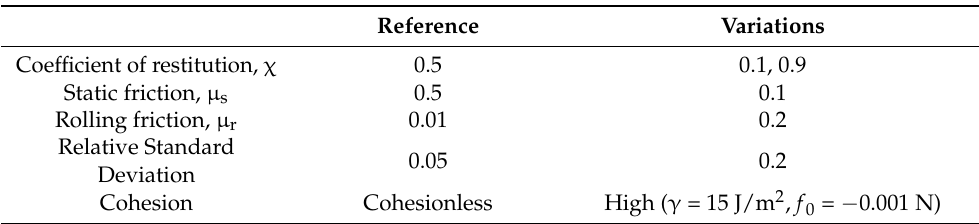
Table 4. Variations from the reference case defined in Table 3, where χ , µ s and µ r apply to both particle–particle and particle–geometry